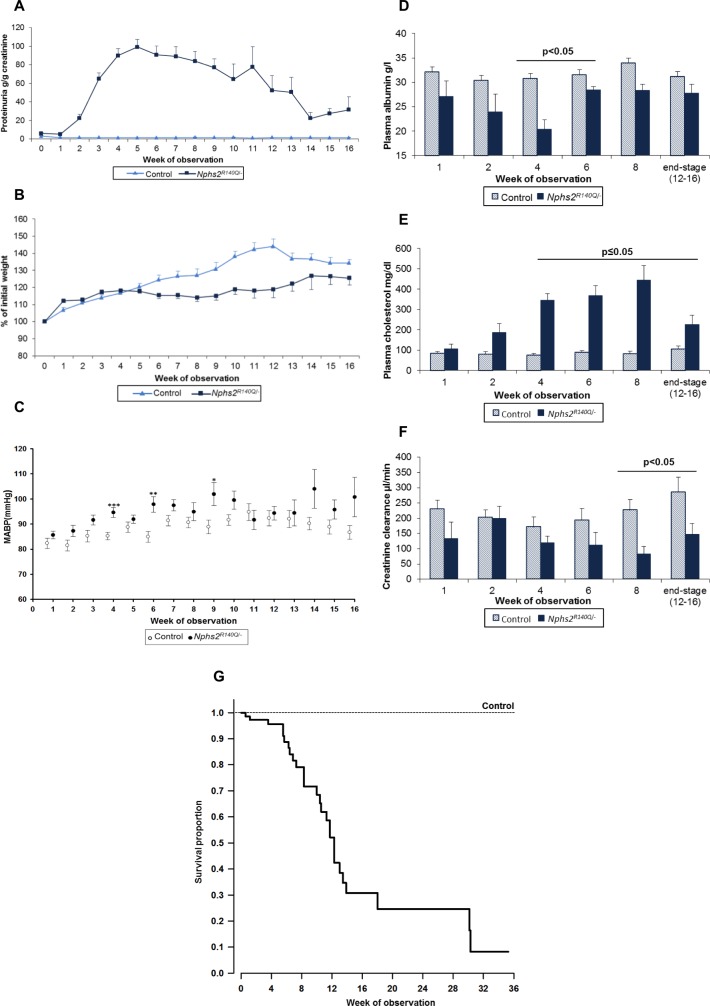
Nphs2R140Q/- mice develop nephrotic syndrome.(A) Induced mice develop proteinuria (control n = 49; Nphs2R140Q/- n = 57; p<0.0001), (B) display diminished weight gain (control n = 49; Nphs2R140Q/- n = 57) and (C) moderately increased mean arterial blood pressure (MABP) (control n = 25; Nphs2R140Q/- n = 34; * p<0.05, ** p<0.005, *** p<0.001 vs. controls at the same time points). (D-F) Nphs2R140Q/- mice display significant hypoalbuminemia, hypercholesterolemia and diminished creatinine clearance (columns represent 4–10 animals per group and time point). (G) Kaplan-Meier analysis of survival of 76 Nphs2R140Q/- mice following induction vs. 30 healthy controls. Median survival time was 12 (95% CI: 11–13) weeks (p<0.01).